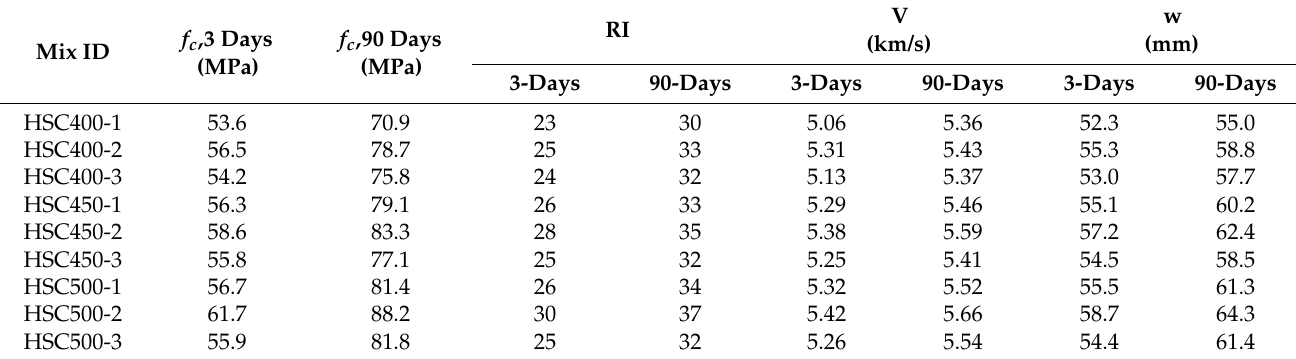
Table 3. Values of destructive and non-destructive test